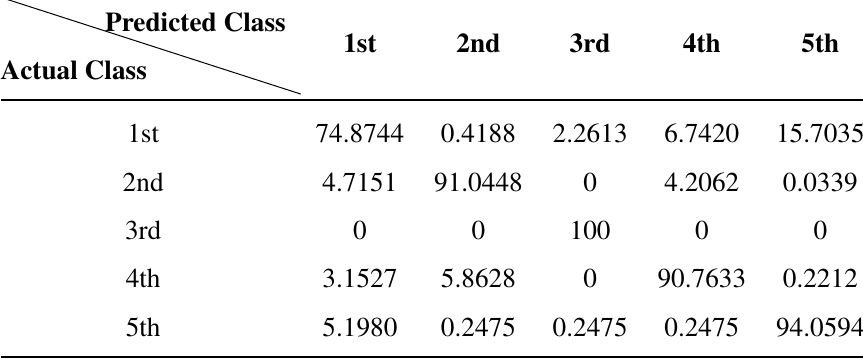
Table 9. Confusion matrix for SVM, mean shift-filtered patches, 500 × 500-pixel patches and parameter Set IV (values in %).